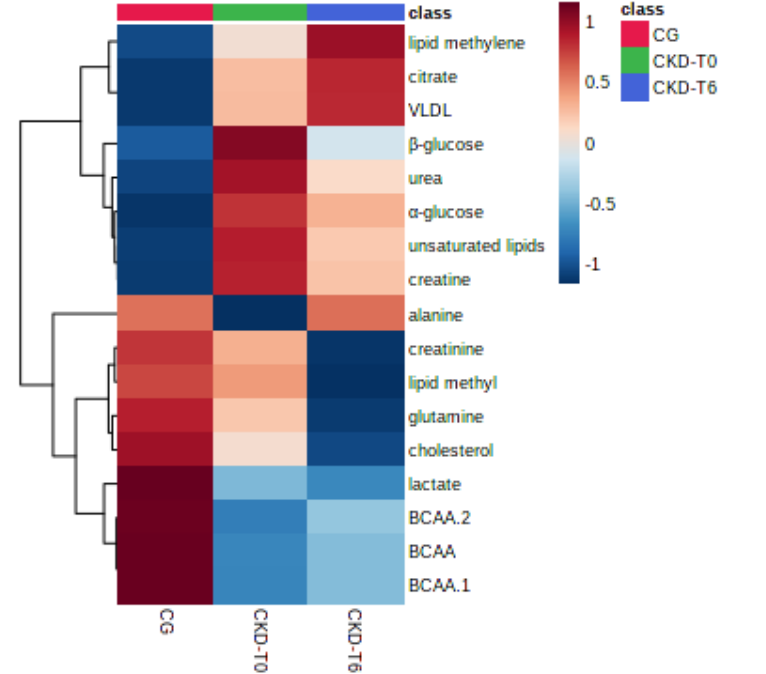
Figure 3 . Hierarchical clustering heatmap of a targeted PLS-DA of 1 H NMR data of dogs’ serum showing the main metabolites’ average levels for each group. CG: control group (healthy animals);